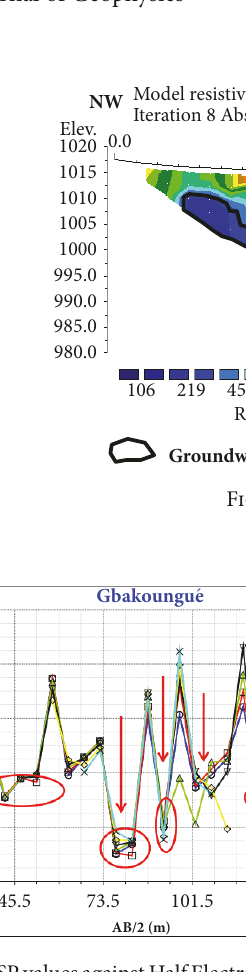
Figure12:PlotsofSPvaluesagainstHalfElectrodesSpacing(AB/2).